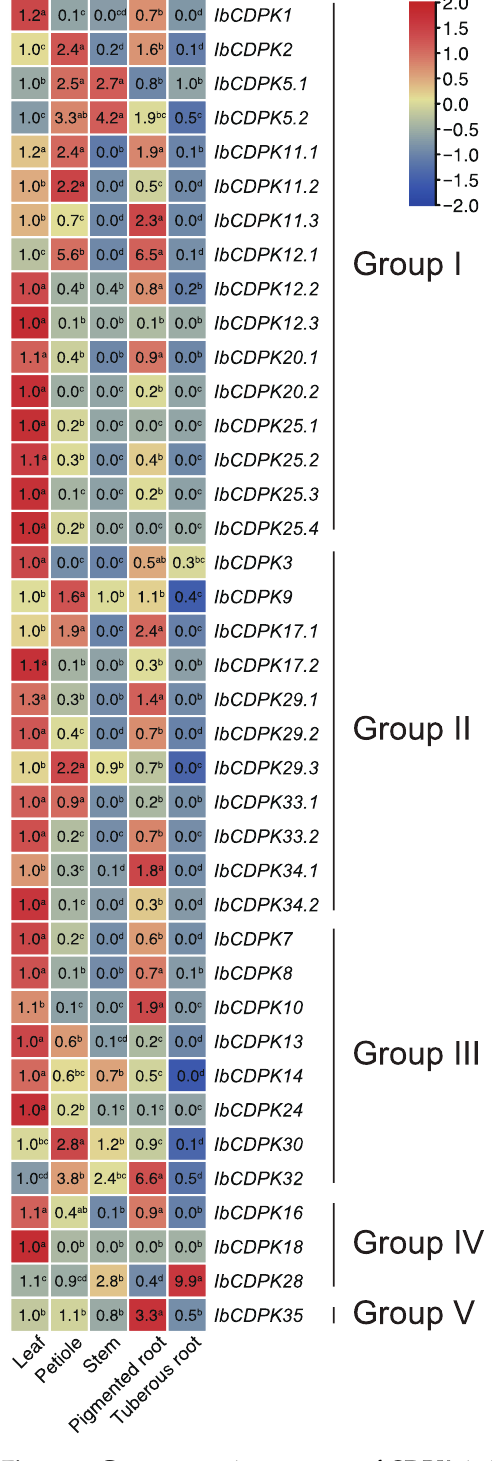
Figure 6. Gene expression patterns of CDPKs in leaf, petiole, stem, pigmented root, and tuberous root of I. batatas. The values were determined by RT-qPCR from three biological replicates consisting of pools of three plants, and the results were analyzed using the comparative C T method. The fold change is shown in the boxes. Different lowercase letters indicate significant differences ( p < 0.05; Student’s t -test).